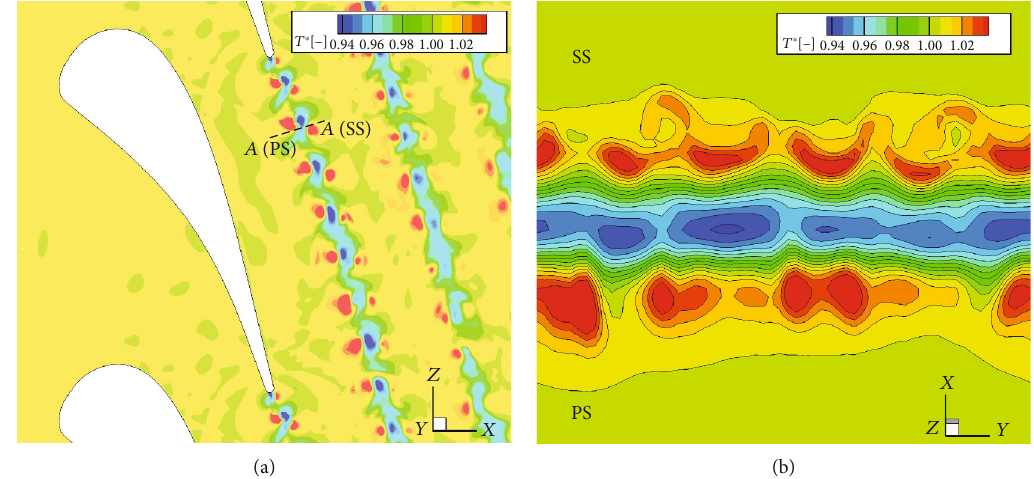
Figure 19: Time-resolved total temperature distribution in wakes: (a) overview; (b) A ‐ A pro fi